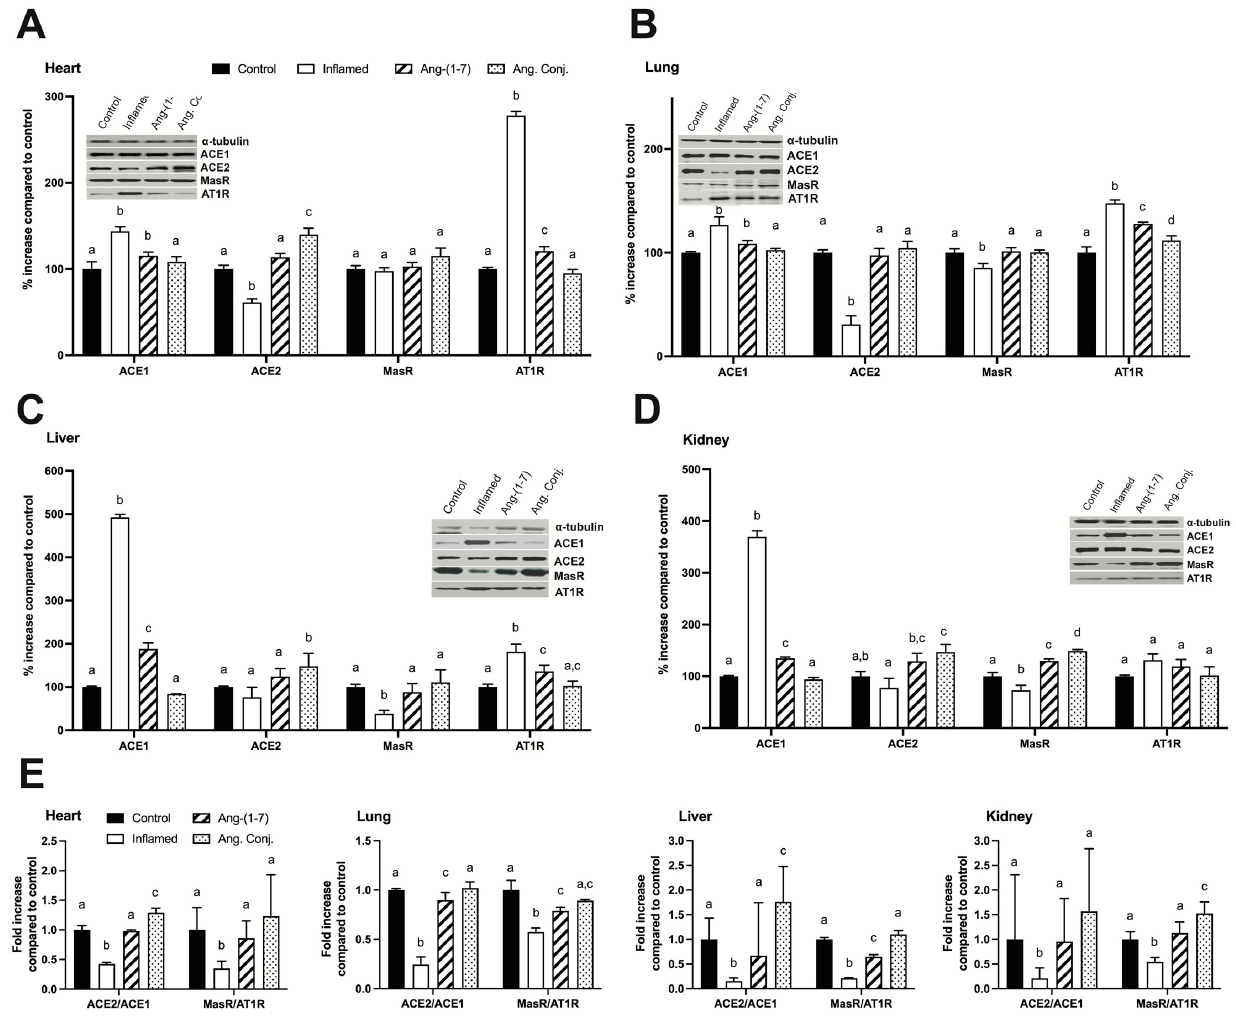
Figure 6. Protein expression of ACE1, ACE2, MasR, and AT1R, levels in the heart ( A ), lung ( B ), liver ( C ), kidney ( D ) tissues, and the ratio of ACE2/ACE1 and MasR/AT1R ( E ) in control ( n = 6), inflamed ( n = 6), Ang-(1-7)-treated ( n = 5), and Ang. Conj.-treated ( n = 5) groups. ACE1—angiotensin-converting enzyme 1, ACE2—angiotensin-converting enzyme 2, MasR—Mas receptor, AT1R—angiotensin II type 1 receptor. The values are reported as mean ± SEM, and statistical analysis was done using one-way ANOVA with the Tukey multiple comparison post-hoc test. Groups labeled with different letters have significant differences between them ( p < 0.05).